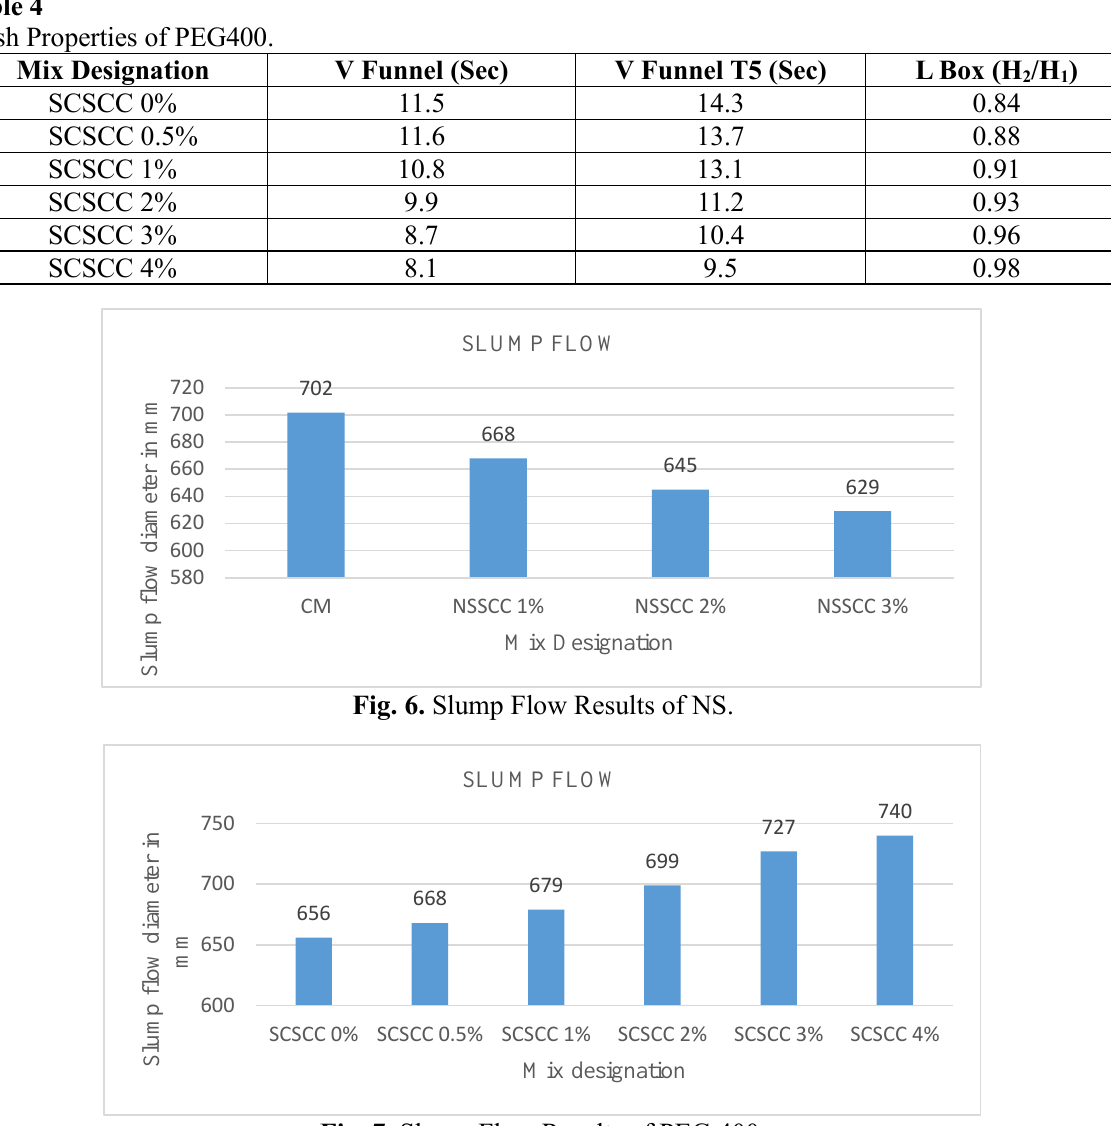
Fig. 7. Slump Flow Results of PEG